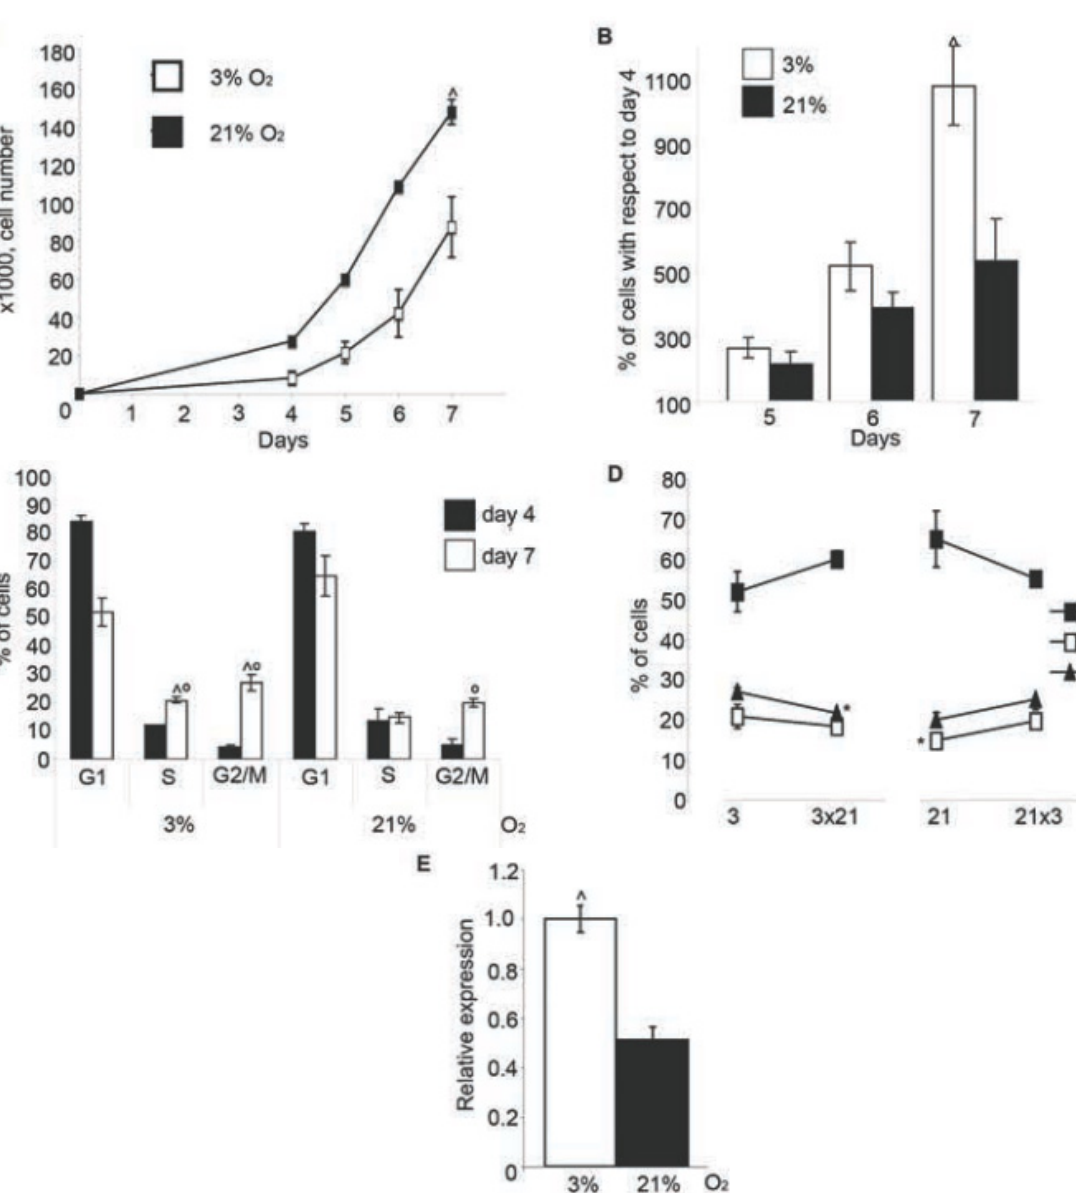
Figure 2. Effect of 3% O on the BMSC growth. ( A ) BMSC were seeded in 2 quadruplicates, as described in the methods section, and cultured for seven days. Starting from day 4, cells were counted daily. Results are presented as number of cells recovered from cm 2 of culture dish; ( B ) BMSC were cultured as in A. Number of cells at days 5, 6 and 7 are presented as percentage to day 4; ( C ) Cell cycle analysis of BMSC cultured for four (day 4) or seven (day 7) days; ( D ) Cell cycle analysis of BMSC cultured for seven days in 3% (3 × 3) or 21% O (21 × 21), or cultured for 4 days in 3% O with subsequent 2 2 switch to 21% for three days (3 × 21) or vice versa (21 × 3); ( E ) Expression of Vegfr1 in BMSC cultured for one week as estimated by qPCR. The difference is significant at p < 0.05: ^ for cells cultured in 3% and 21% O ; º for cells at day 4 and day 7 of culture; 2 and vice * for cells switched from 3% to 21% O 2